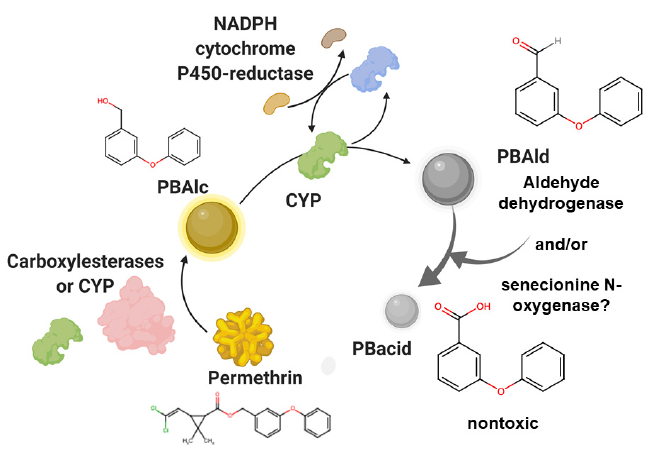
Figure 2. Pyrethroid detoxification cascade is mediated by carboxylesterases (COEs), cytochrome P450s (CYP6, CYP9) and other oxidation/reduction proteins. Permethrin is converted to PBAlc (phenoxybenzyl alcohol) by COEs and/or CYP9/CYP6 [45]. The metabolic intermediate PBAlc is converted to PBAld (3-phenoxybenzaldehyde). Aldehyde dehydrogenase is a demonstrated oxidizer of PBacid [54]. PBAc is nontoxic in larvae [45]. Recent genetic association evidence also implicated senecionine N-oxygenase as a possible player in pyrethroid resistance [31,89]. Proposed involvement of aldehyde dehydrogenase or senecionine N-oxygenase on right. Oxidized groups are shown in red in chemical structures. Figure prepared using Biorender, with permission (Biorender.com, accessed on 22 March 2021).